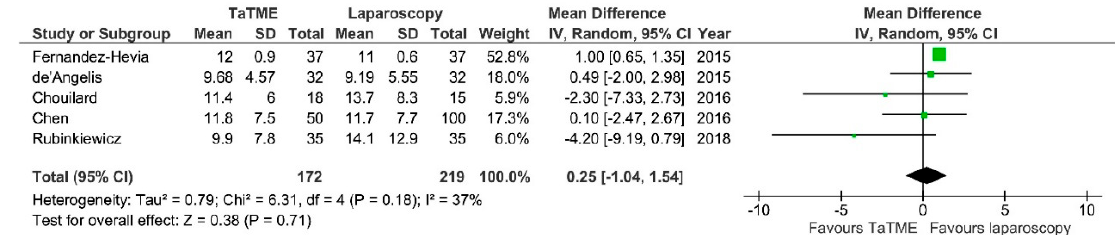
Figure 11. Circumferential resection margin. CI—Confidence Interval; df—degrees of freedom; IV— IV—inverse variance. WMD and RR are presented on the graphs as squares, and overall WMD